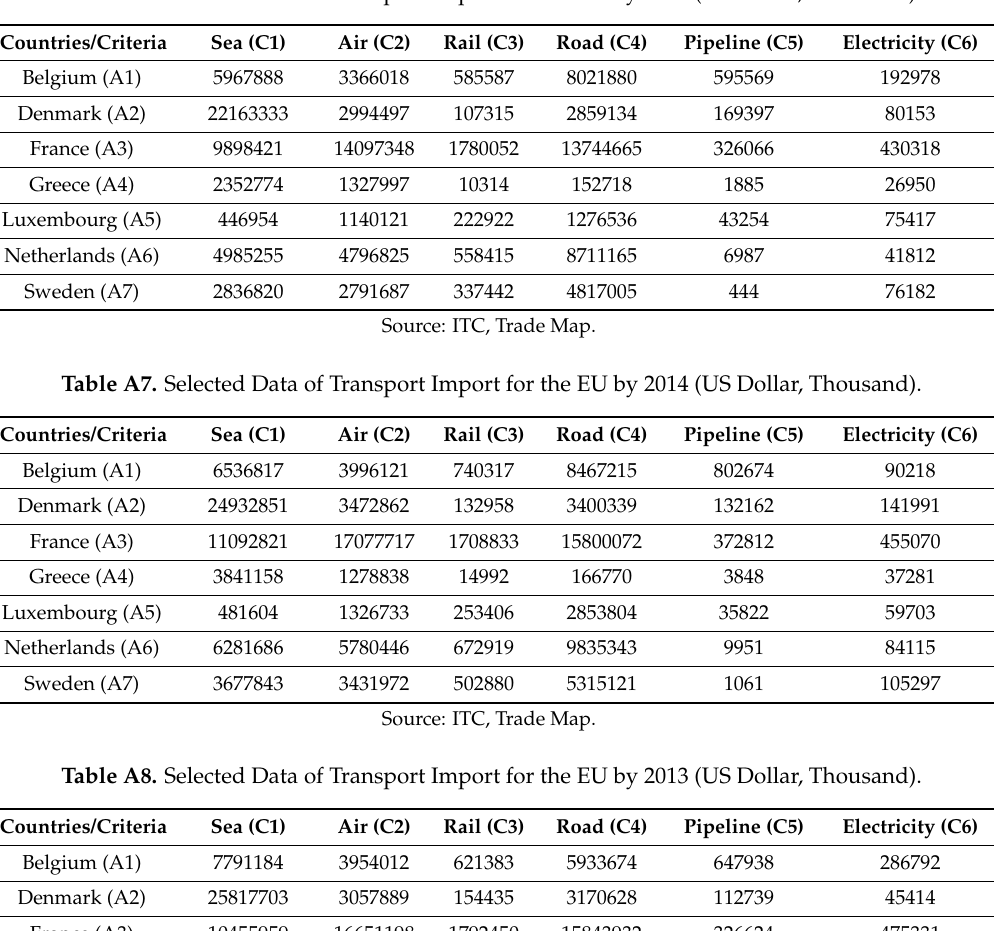
Table A6. Selected Data of Transport Import for the EU by 2015 (US Dollar, Thousand).